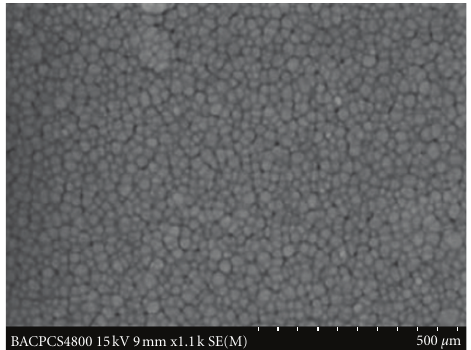
Figure 6: SEM image of ZnO nanorods/TiO 2 photoanode.